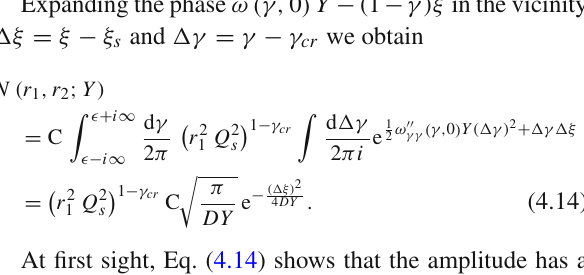
Fig. 3 a − (cid:8) N (τ) = −∇ 2 N (τ) = − 4 τ 1 τ d versus τ for the behavior of